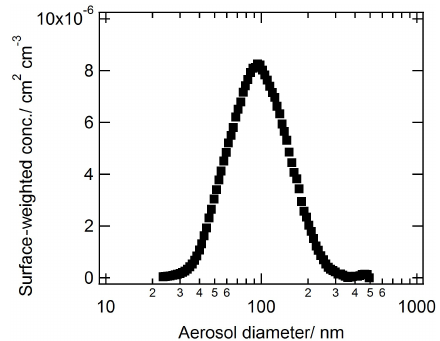
Figure 2. An example of the size distribution for α -pinene-derived aerosol particles formed in the PAM chamber at a relative humidity of ∼